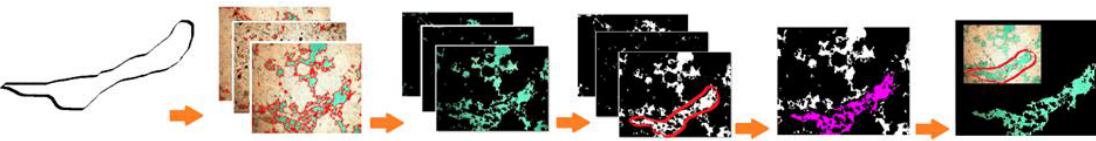
Figure 1. An example of the functioning of the Query by Sketch when retrieving similar objects in a microscopic image (sketch, segmentation of images in a database, comparing features against specific criteria, detection of the most similar objects, visualization of the query and the object found).